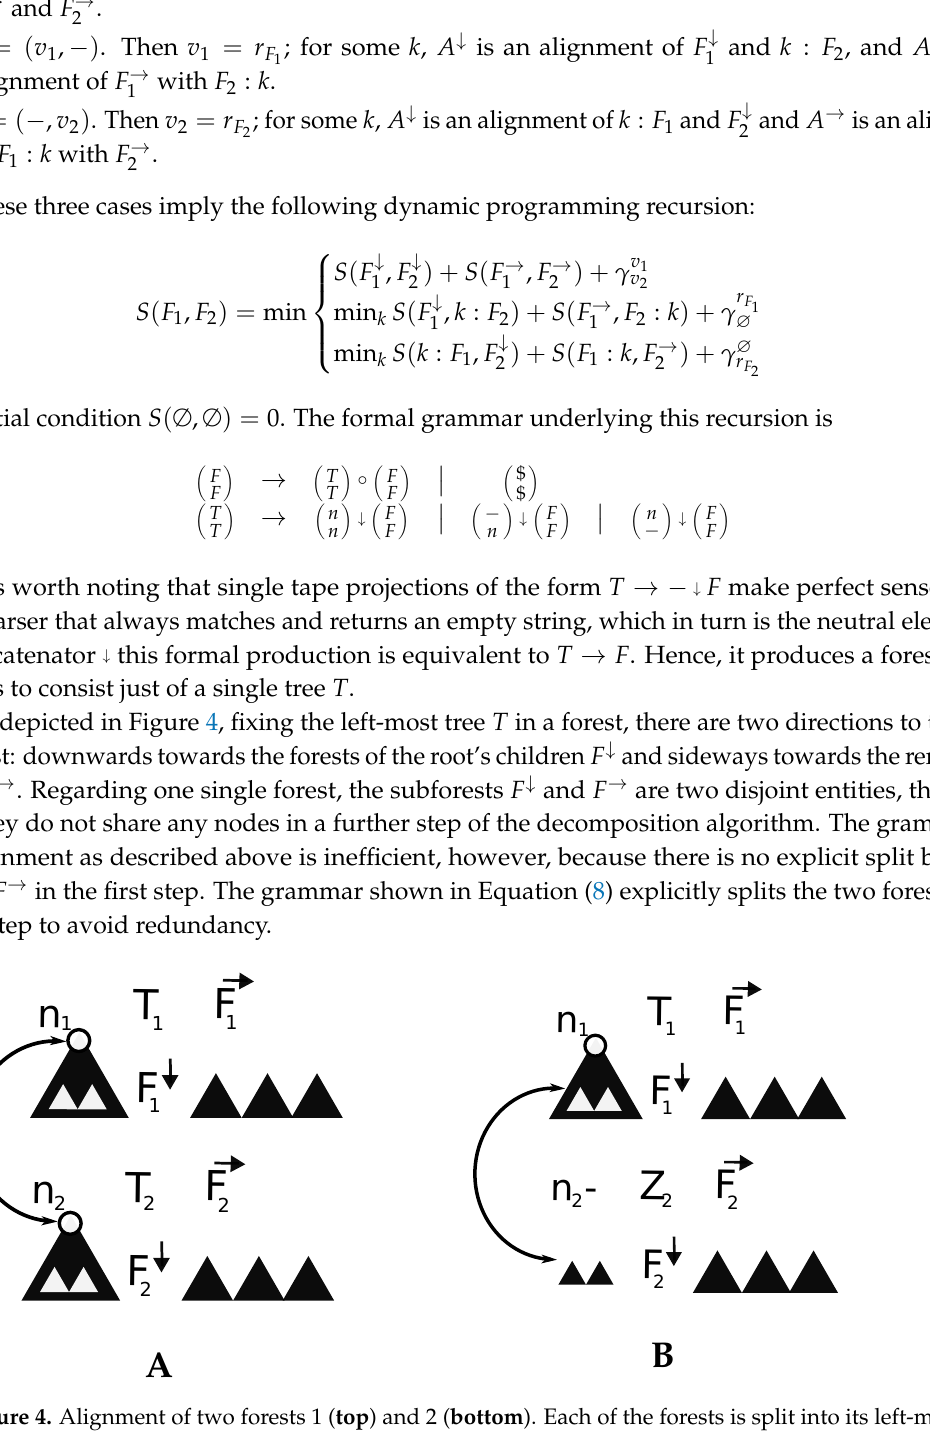
, F → . ( A ) The left-most tree will be split into its root nodes 2 1 , F ↓ . ( B ) In case n 2 is deleted, a gap symbol Z 2 is added and the 2 1 and F ↓ 2 1